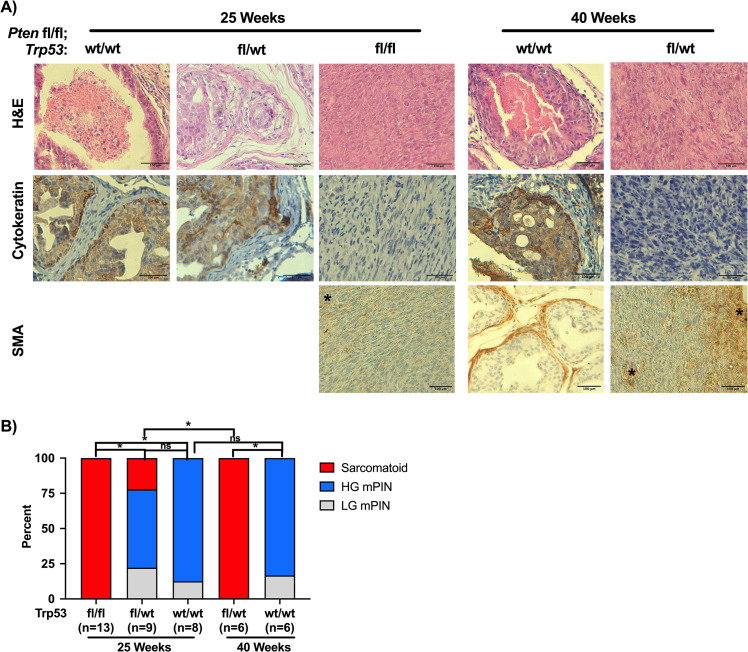
Histopathology analysis of WT, HET, and DKO tumors.(A) Representative sections of tissue form DKO mice, as well as both HET and WT at 25 and ~40 weeks. Disease stage was determined by pathologist review of H&E sections, with sarcomatoid being confirmed with a negative pan-cytokeratin stain. Bar = 100μm. Asterisks denote small patches of SMA-positivity. (B) Histopathology analysis from H&E and cyokeratin staining in (A), (*p>0.05; Chi-Square with Bonferroni correction).